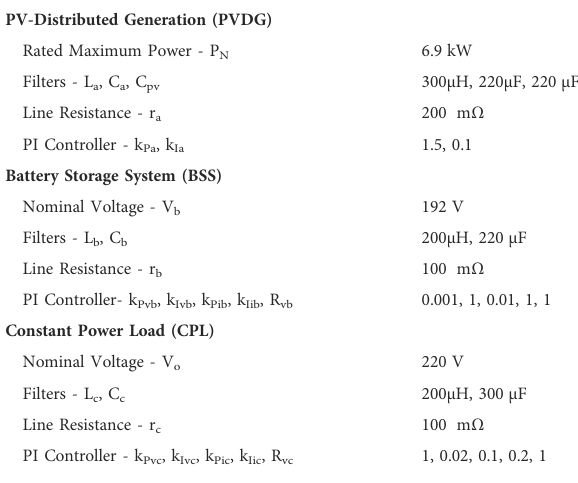
TABLE 2 Parameters of PV-battery-load-based DC microgrid